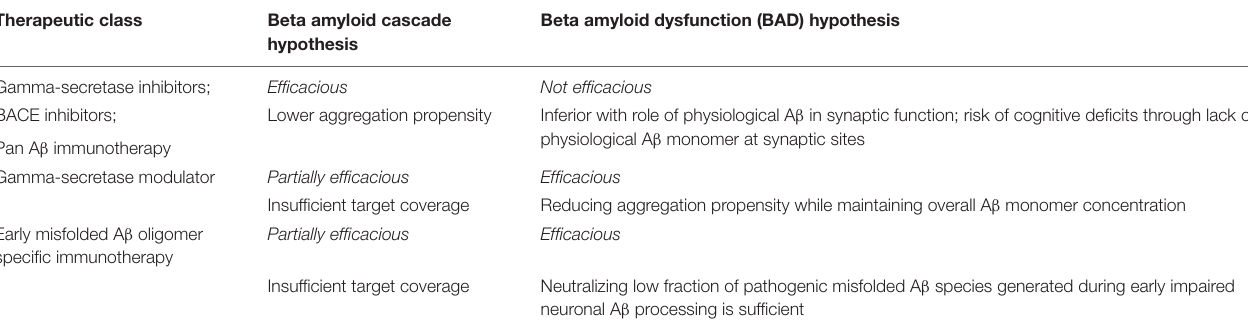
TABLE 3 | BAD vs. cascade hypothesis: prediction of clinical results for major therapeutic